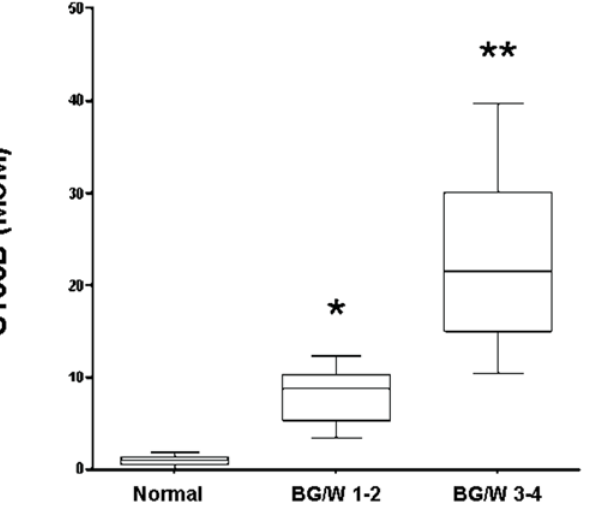
Figure 2. Saliva levels of S100B in neonates with normal, BG/W score 1 – 2 and BG/W score 3 – 4. The box plots represent the medians and interquartile ranges for each group. ** P < 0.001 global BG/W vs severe BG/W injury; * P < 0.001 vs normal MRI